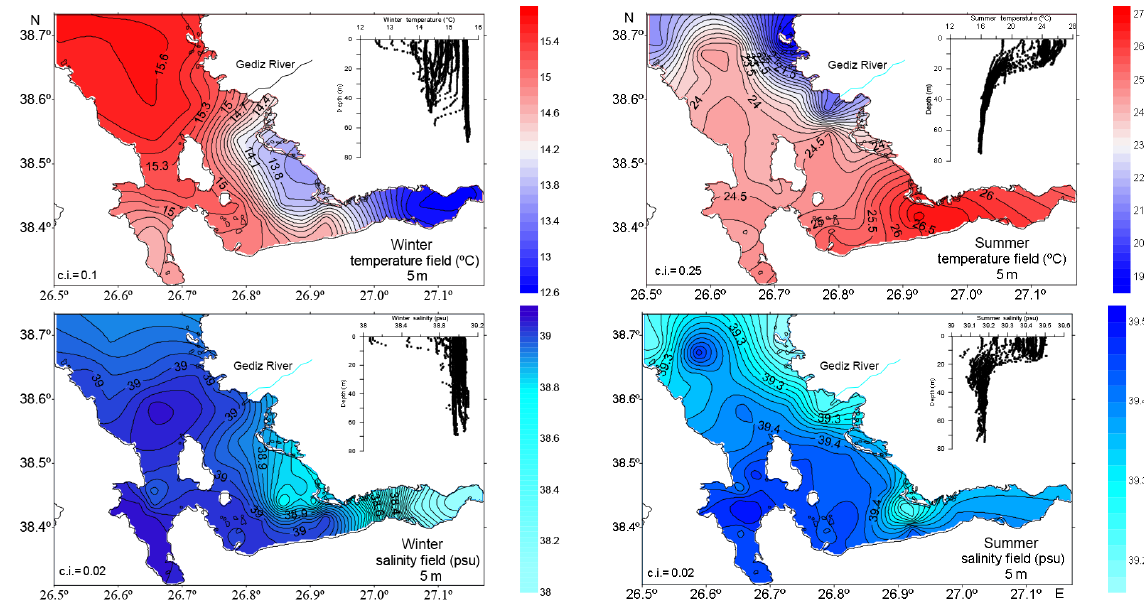
Figure 2. The winter and summer temperature and salinity fields given by the model as temperature and salinity distributions of the first level. The related profiles are at the upper-right corner of the